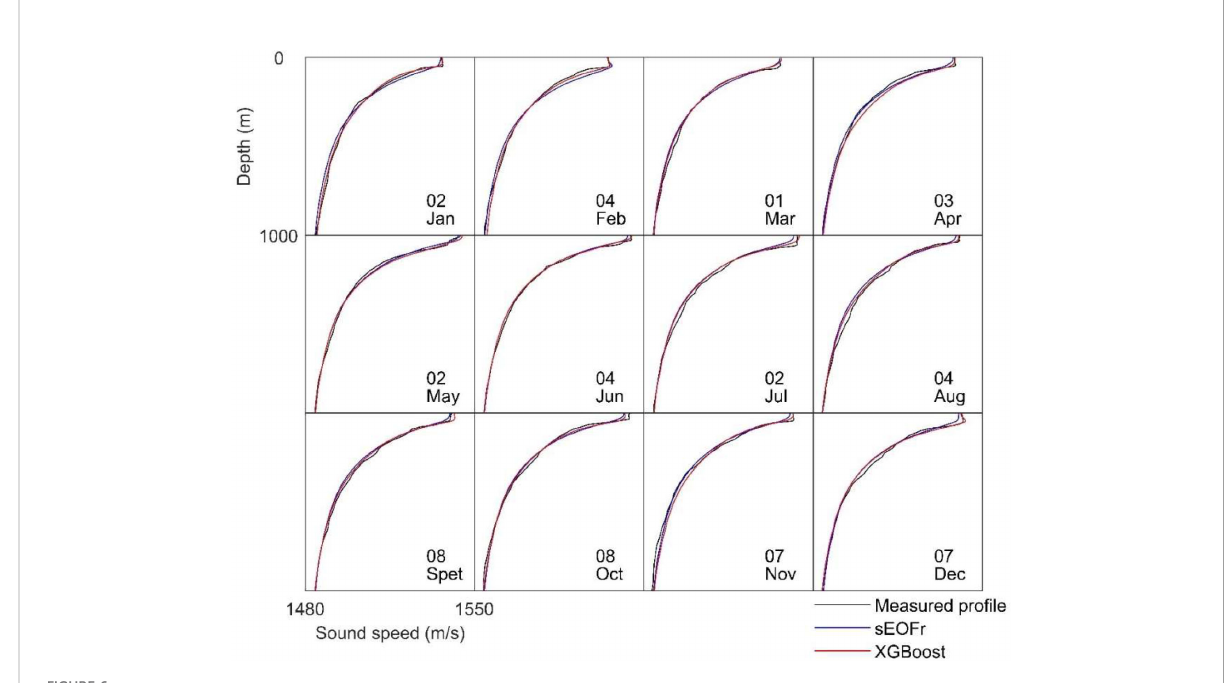
FIGURE 6 Reconstruction results of the fi rst effective pro fi le for each